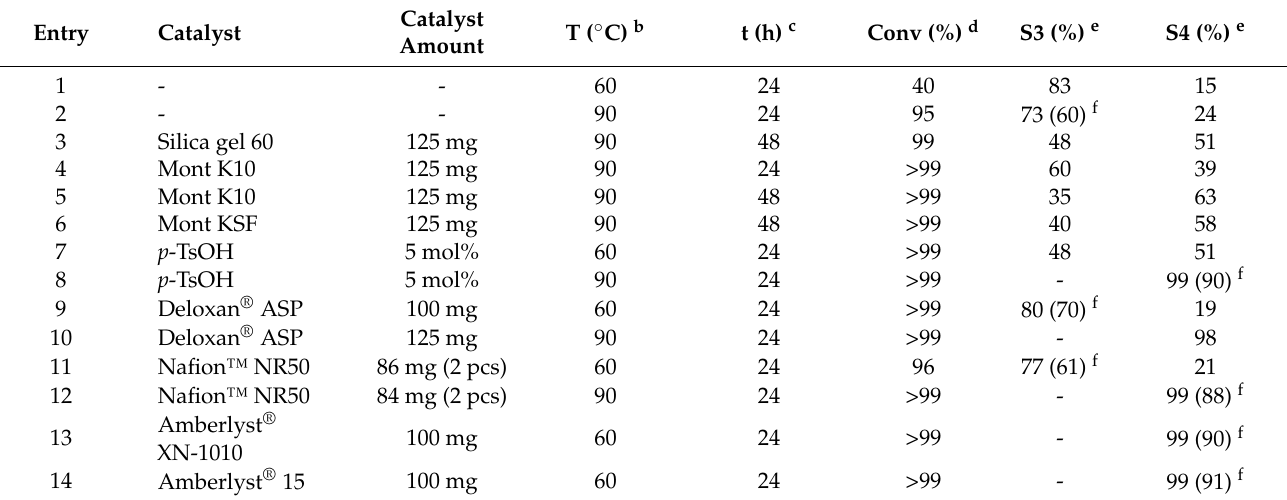
Table 1. Effect of the catalyst in the reaction of 1 and 2 a